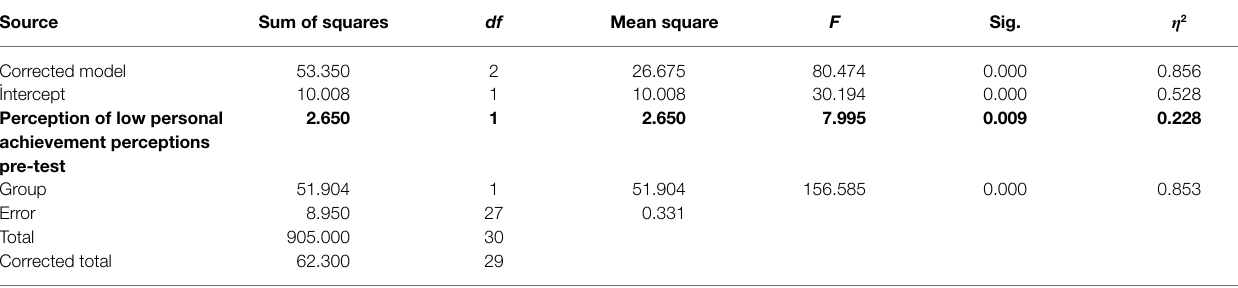
TABLE 8 | Analysis results regarding perception of low personal achievement perceptions. Source Sum of squares df Mean square F